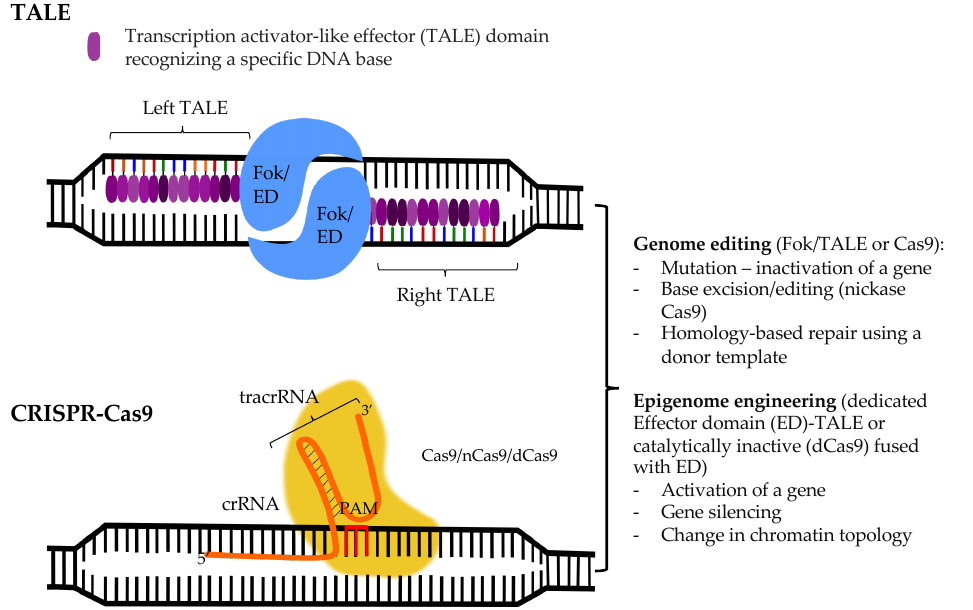
Figure 2. Mechanisms of action of TALE (upper panel) and CRISPR-(d)Cas9 (lower panel). In the TALE system, a designed protein chimera, consisting of transcription activator-like domains (TAL) each recognizing a specific base in the DNA molecule, binds to the target sequence. Fused with a chosen effector domain (ED), TAL effectors (TALEs) can tether a desired enzymatic activity to the target site. This way TALEs can be used to modify the DNA sequence (when endonuclease FokI is the ED) or alter the chromatin landscape. The later can be achieved by fusing TAL with for instance VP16 transactivation domain or the enzymatic domain of p300 HAT allowing to enhance gene expression. Fusion of TAL with KRAB and MeCP2 can induce locus silencing. In CRISPR-Cas9 system, a single guide RNA molecule (sgRNA: guide RNA fused with tracrRNA), harboring a region complementary to the locus of interest, stabilizes the binding of the Cas9 endonuclease and favors the introduction of a double- (Cas9) or a single-strand (nickase-Cas9) DNA break at the recognized site and mutation in the target DNA sequence. When using a catalytically inactive Cas9 (dCas9), this system can also be harnessed to tether an ED to a locus of interest. The dCas9-based epigenome engineering can also be used to modify genome topology and re-introduce promoter-enhancer